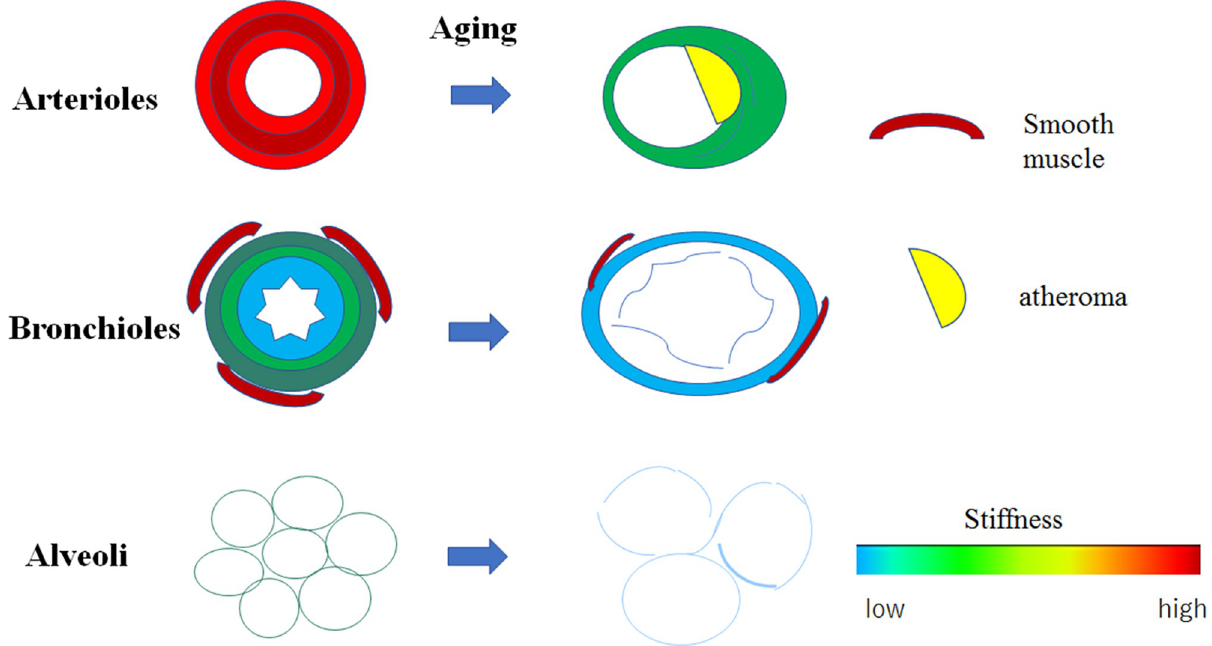
Fig 10. Schematic images showing alterations associated with aging in the arterioles, bronchioles, and alveoli. Young arterioles consist of thick, smooth muscles and elastic fibers in the medial layer. Conversely, old arterioles are composed of few smooth muscles and elastic fibers with dilatation and focal atheromatous deposits in the intimal layer. The stiffness of young arterioles is higher than that of the old arterioles. Young bronchioles consist of thick, dense connective tissue with few smooth muscles, whereas old bronchioles are composed of loose connective tissue with sparse smooth muscles. Therefore, the stiffness of old bronchioles is lower than that of the young bronchioles; the old bronchioles are also dilated. Young alveoli are composed of continuous walls with a regular size, whereas old alveoli consist of discontinuous walls in larger irregular sizes, resulting in loss of stiffness.